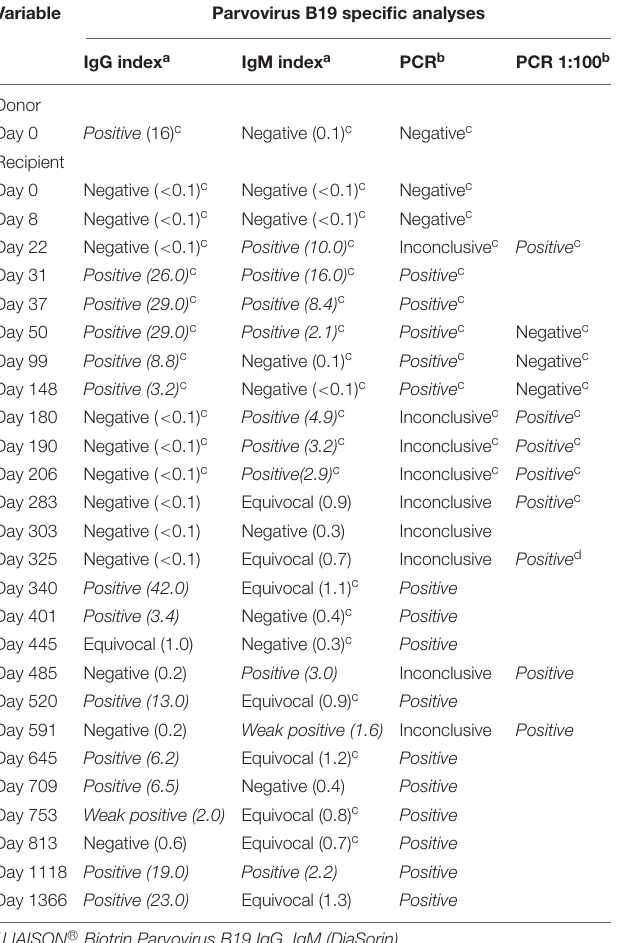
TABLE 1 | Parvovirus B19 serologic status and parvovirus B19 PCR of the recipient and donor at different times after transplantation. Variable Parvovirus B19 specific analyses